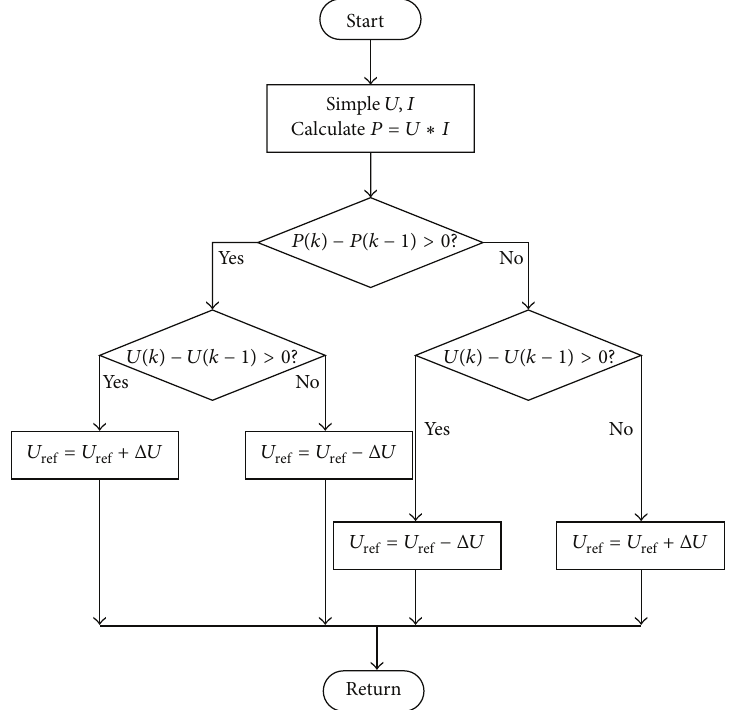
Figure 7: The flowchart of classical perturb-and-observe